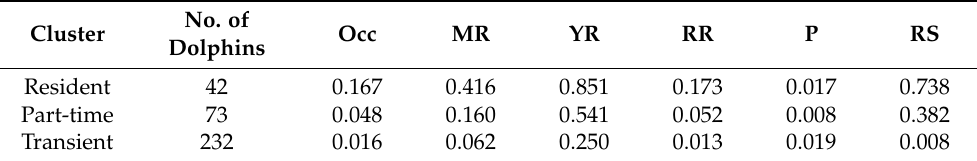
Table 1. Cluster numerosity and centroids of the site-fidelity metrics: occurrence (Occ), monthly rate (MR), yearly rate (YR), re-sighting rate (RR), periodicity (P), and relative span-time (RS). No. of Occ MR YR RR P RS Cluster Dolphins Resident 42 0.167 0.416 0.851 0.173 0.017 0.738 Part-time 73 0.048 0.160 0.541 0.052 0.008 0.382 Transient 232 0.016 0.062 0.250 0.013 0.019